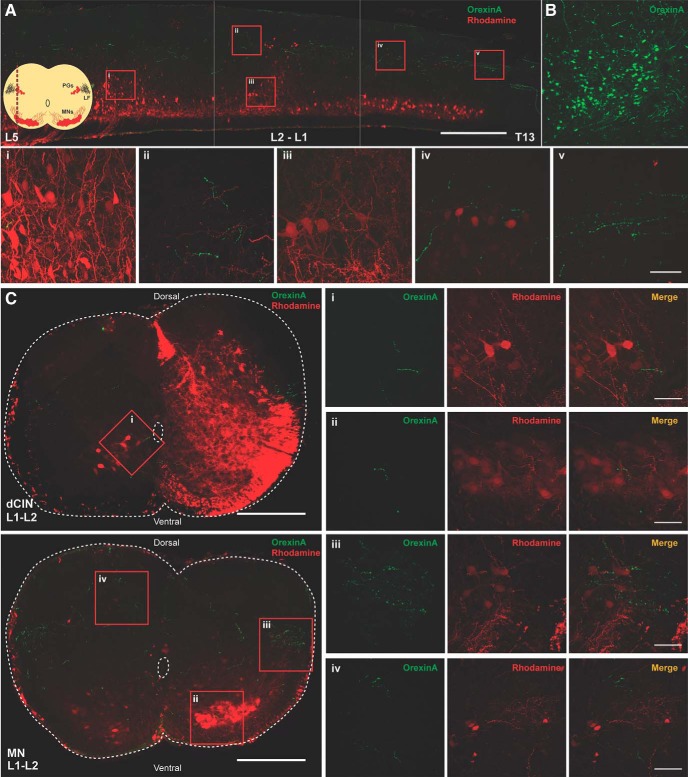
Orexinergic innervation of the developing (P3) spinal cord. A, Longitudinal section of spinal cord (30 μm) showing numerous orexinergic fibers projecting along the lateral funiculus throughout the lumbar spinal cord. Scale bar, 500 µm. Corner schematic shows the location of the longitudinal section (LF, lateral funiculus; PG, preganglionic motor neurons); 60× confocal images of select regions (scale bar, 50 µm): i, sparse orexinergic fibers around MNs in lumbar region; ii, dorsal fibers in the L1-L2 region; iii, rare fiber passing by L1-L2 MNs; iv, orexinergic fibers exiting the LF around the preganglionic MNs; v, orexinergic fibers in the LF, varicosities are evident. B, Positive control showing OXergic neurons in lateral hypothalamus. C, Transverse sections of L1-L2 spinal cord with rhodamine-labeled dCINs and rhodamine-labeled ventral MNs (scale bar, 250 µm); 60× confocal images of select regions (scale bar, 50 µm): i, orexinergic fibers apposing dCINs; ii, sparse fibers in MN pool; iii, orexinergic fibers exiting the LF around the preganglionic MNs; iv, dorsal fibers are prevalent.